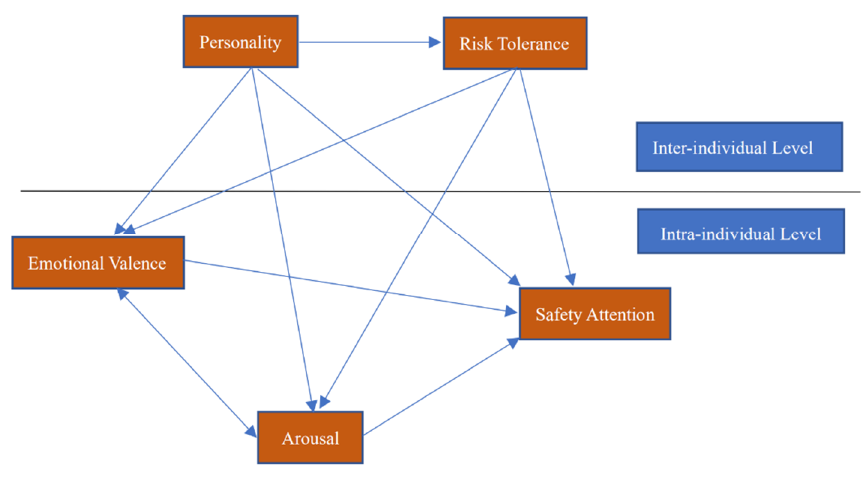
Figure 1. Theoretical model.